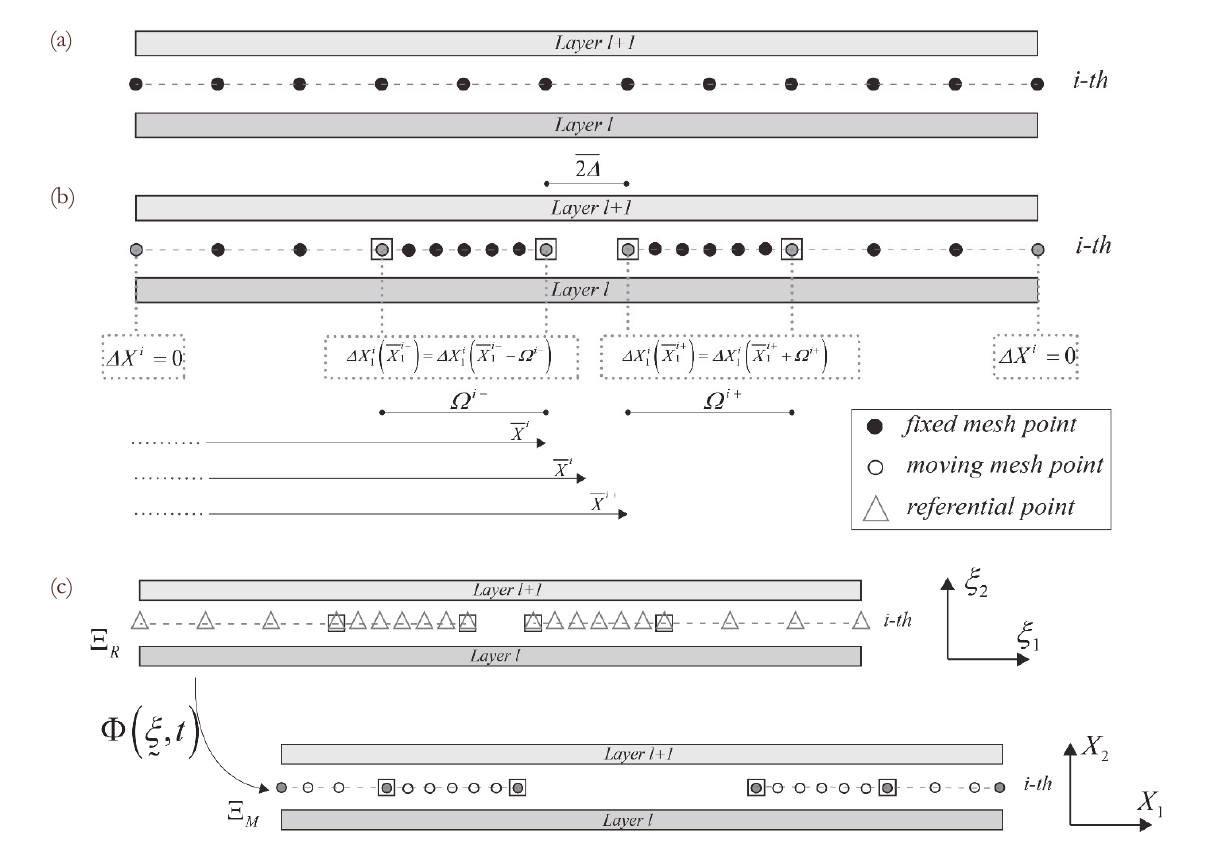
Figure 2: Representation of the coordinate systems employed: Before crack initiation (a), After crack initiation, material and moving coordinates systems are coincident (b), ALE formulation: referential and moving configuration introduced to described debonding phenomena